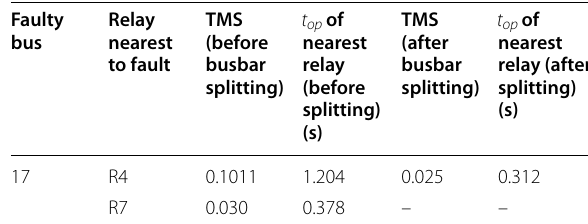
Table 7 TMS and t op of relays nearest to fault location